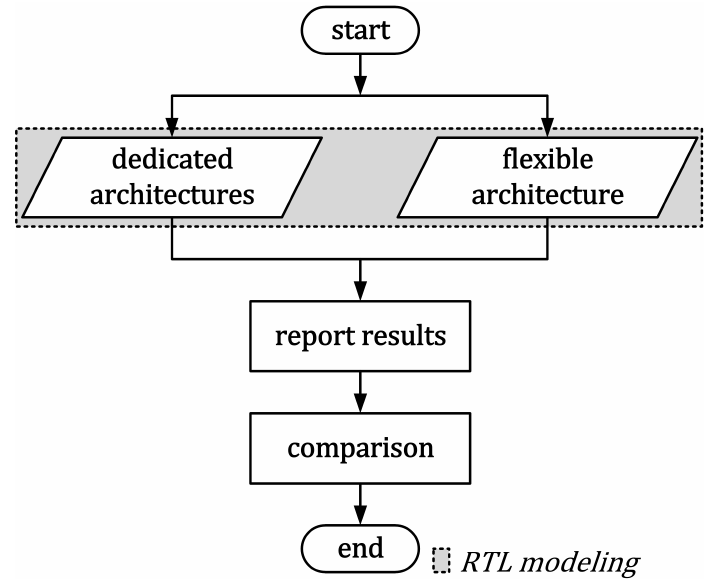
Figure 1. Flowchart of our dedicated and scalable multiplier architectures. Algorithm 1: Pseudocode of our dedicated and scalable multiplier